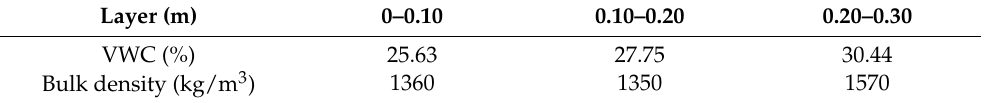
Table 3. VWC and bulk density of different soil layers in field experiments.